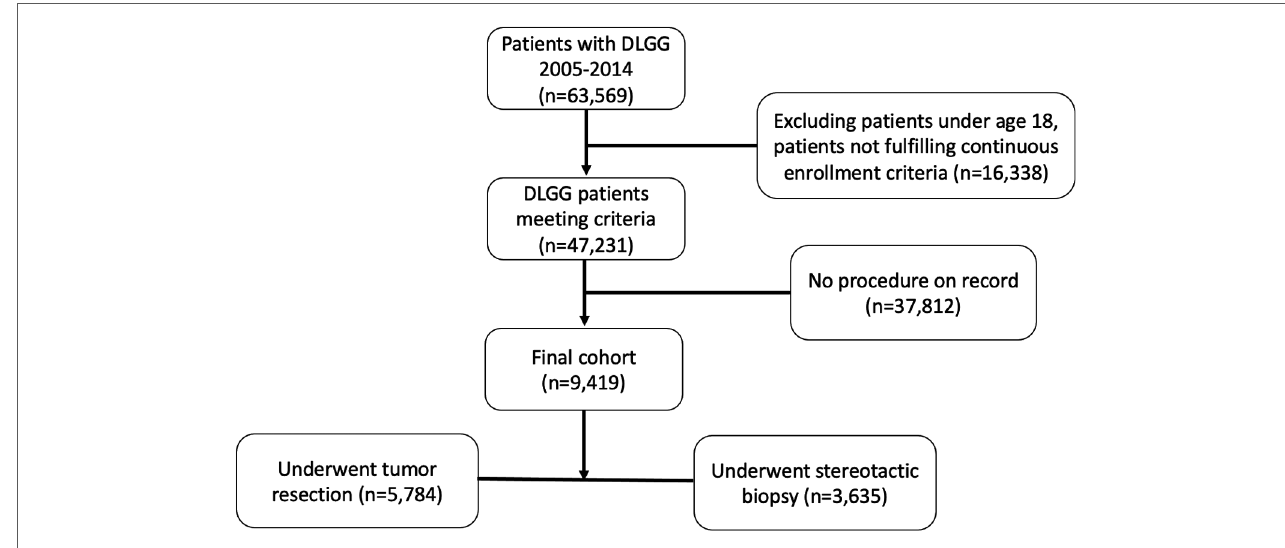
FIGURE 1 Flow chart for case identi fi cation and